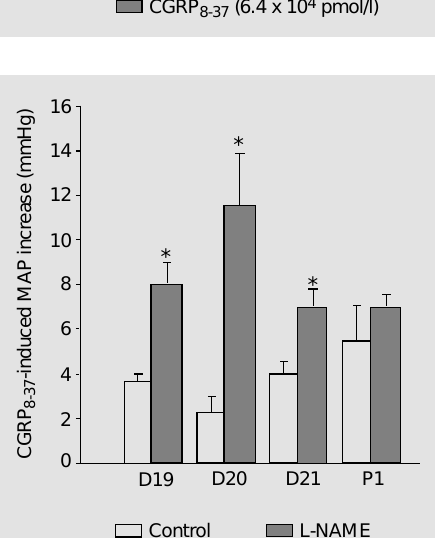
Figure 1. The calcitonin gene-re- lated peptide receptor antago- nist CGRP 8-37 increases mean arterial pressure (MAP) in deoxy- corticosterone (DOC)-salt hyper- tensive rats but not normoten- sive controls. Rats were instru- mented for continuous MAP re- cording and antagonist adminis- tration as described in the text. With the rats fully awake and unrestrained, bolus doses of the indicated amounts of CGRP 8-37 were given. *P>0.01, higher vs lower dose of CGRP 8-37 . **P<0.001, DOC-salt (group A) vs each of the four controls at both CGRP 8-37 doses (ANOVA followed by the Tukey-Kramer multiple comparisons test). Figure 2. The calcitonin gene- related peptide receptor antago- nist CGRP 8-37 increases mean arterial pressure (MAP) in the subtotal nephrectomy (SN)-salt hypertensive rats but not nor- motensive controls. Rats were instrumented for continuous MAP recording and antagonist administration. With the rats fully awake and unrestrained, bolus doses of the indicated amounts of CGRP 8-37 were given intravenously. *P<0.05, SN-salt hypertensive vs control rats at the lower CGRP 8-37 dose. **P<0.01, SN-hypertensive vs control rats at the higher CGRP 8-37 dose (ANOVA fol- lowed by the Tukey-Kramer mul- tiple comparisons test).